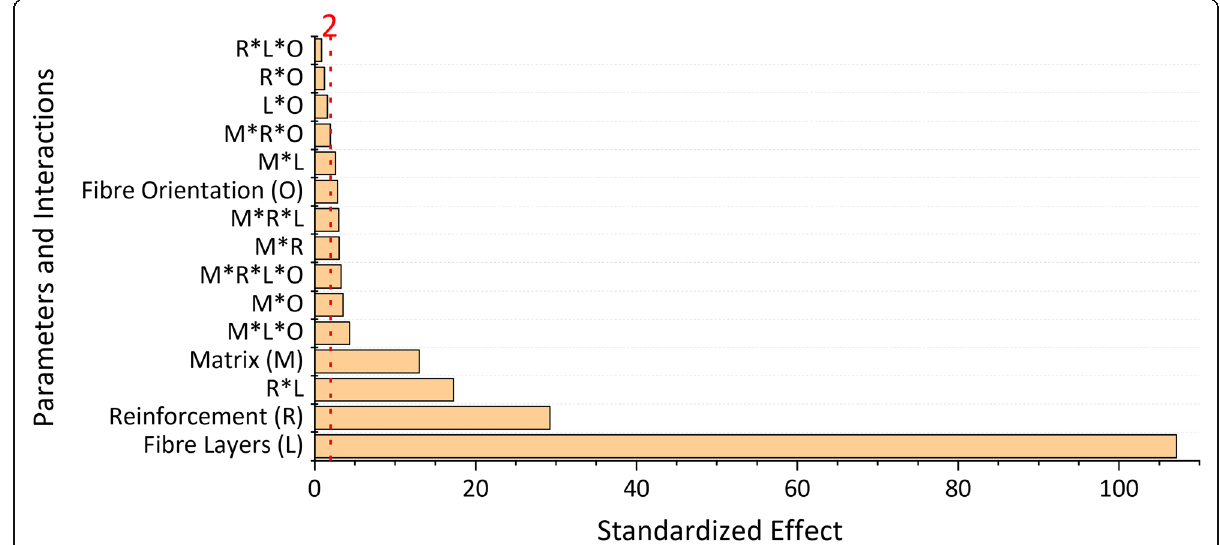
Fig. 3 Pareto Chart for Standardized Parameter Effects for UTS ( α = 0.05). Parameters significant at 95% ( α < 0.05) are those with a Standardised Effect > than the red line. The red line is drawn at t, where t is the (1 – α / 2) quantile of a t-distribution with degrees of freedom equal to the degrees of freedom for the error term (2.0 for UTS and 1.98 for